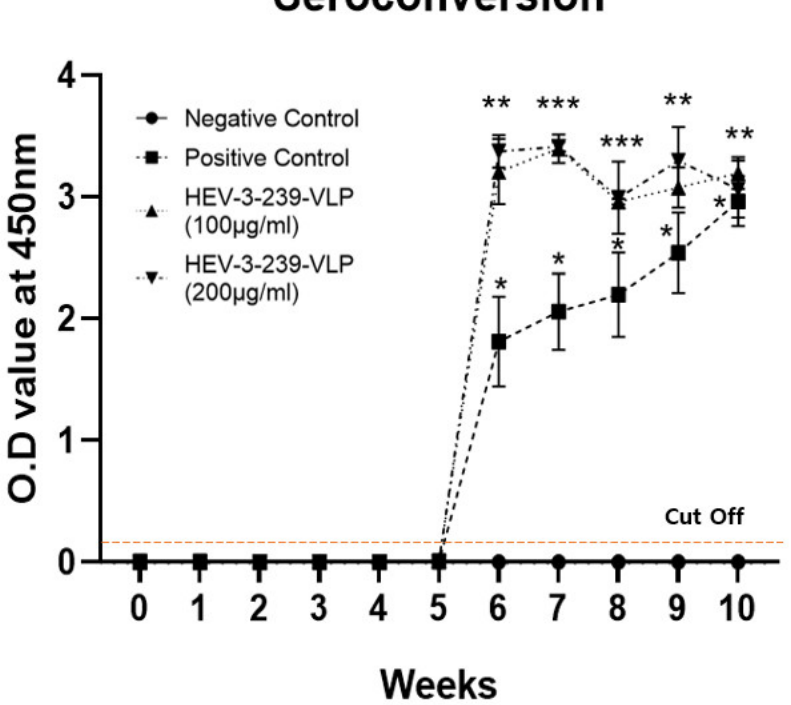
Figure 3. Seroconversion in pigs immunized with HEV-3-239 VLP. In the positive control group, the titer of the anti-HEV antibody increased relatively slowly after the challenge at W 4. In contrast, the titer of anti-HEV antibody in both the vaccinated groups significantly increased after 2 weeks of the viral challenge and was maintained for 5 weeks until the end of the experiment. Statistical analysis was conducted between the vaccinated pigs and negative ones and between the positive and negative control pigs. * p < 0.05, ** p < 0.01, *** p < 0.001.